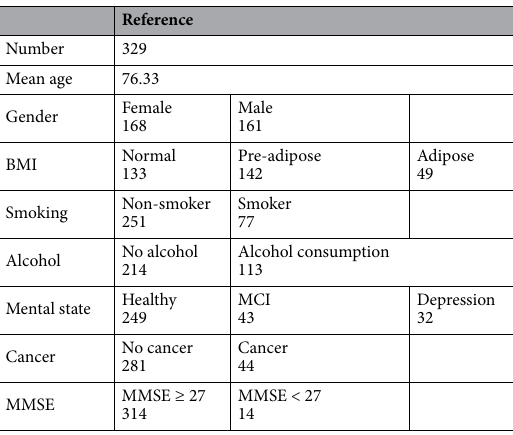
Table 1. Characterisation of recruited reference group with available information at time of sampling.